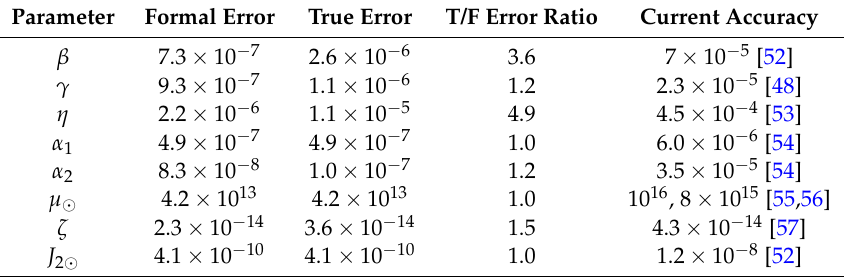
Table 1. Simulation results for the parameters of interest in the MORE relativity experiment (errors on µ (cid:12) are in cm 3 /s 2 , on ζ in y − 1